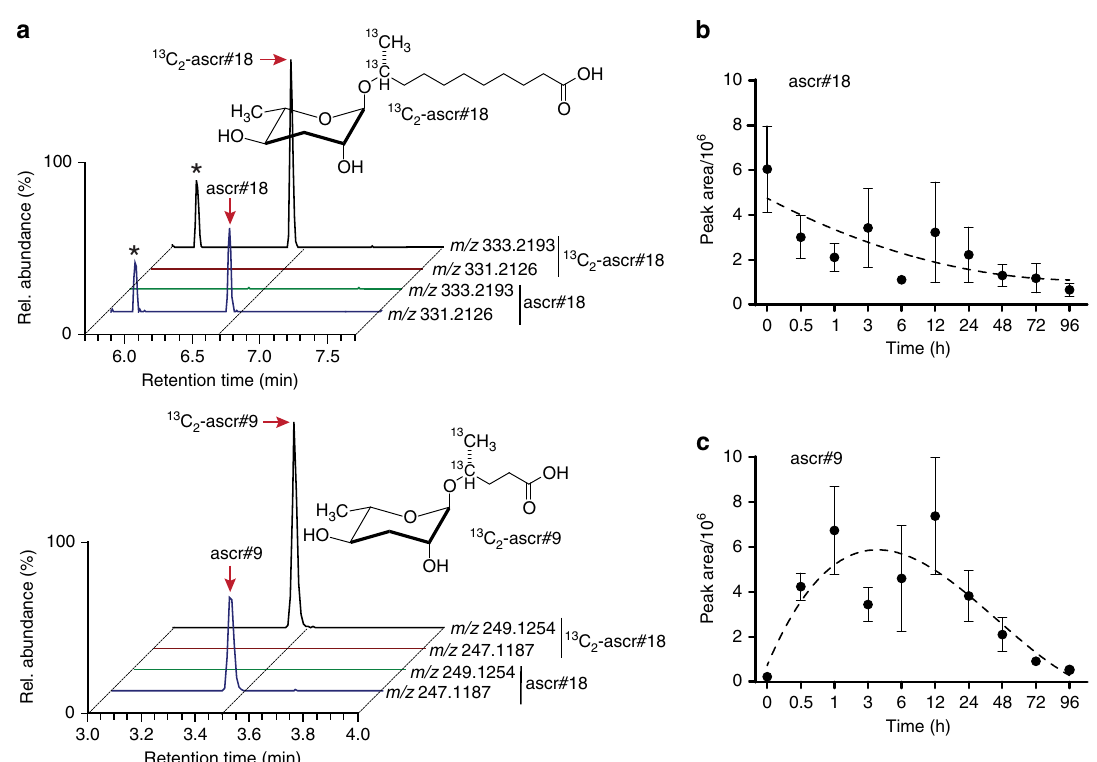
Fig. 2 Short-chained ascarosides are derived from the metabolism of exogenously applied ascr#18. a LC-MS analysis of tomato roots treated with ascr#18 or 13 C 2 -labeled ascr#18. Plants treated with 13 C 2 -labeled ascr#18 show peaks at 333.21932 and 249.12542, representing [M-H] - of 13 C 2 -ascr#18 and 13 C 2 -ascr#9, but not at 331.21261 and 247.11871, which correspond to [M-H] - of ascr#18 and ascr#9, and vice versa. Structures of ascr#18 and ascr#9 indicating the positions of the 13 C 2 -label are shown above ion chromatograms. Peaks marked with an asterisk represent unrelated peaks. b , c Relative abundances of ascr#18 and ascr#9 as measured by LC-MS. Four-week-old Arabidopsis leaves were in fi ltrated with 1 µ M ascr#18, and leaf tissue were harvested for LC-MS analyses over a period of 96 h post in fi ltration of ascr#18. Data are mean ± SEM ( n = 3) (also see Supplementary Fig. 4). Source data are provided as a source data fi